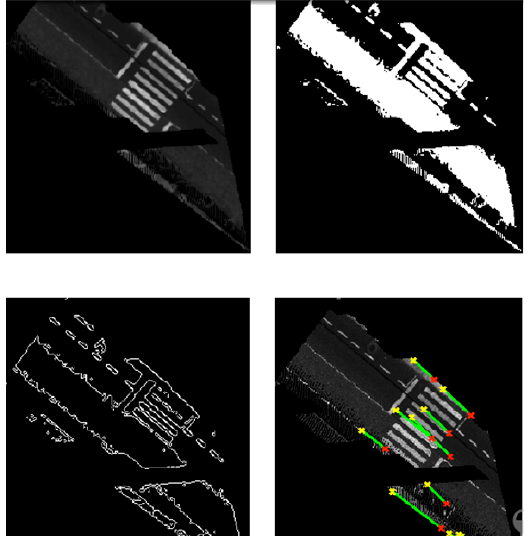
Figure 13. Malfunction of the algorithm due to a deficient reflectivity of the road